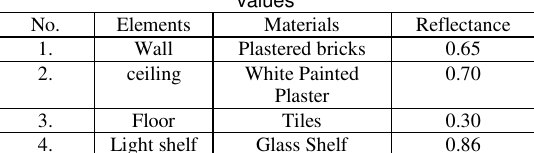
Table 3: Elements, Assigned Materials, and Reflectance